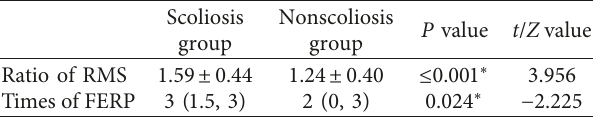
Table 6: SEMG activities in two